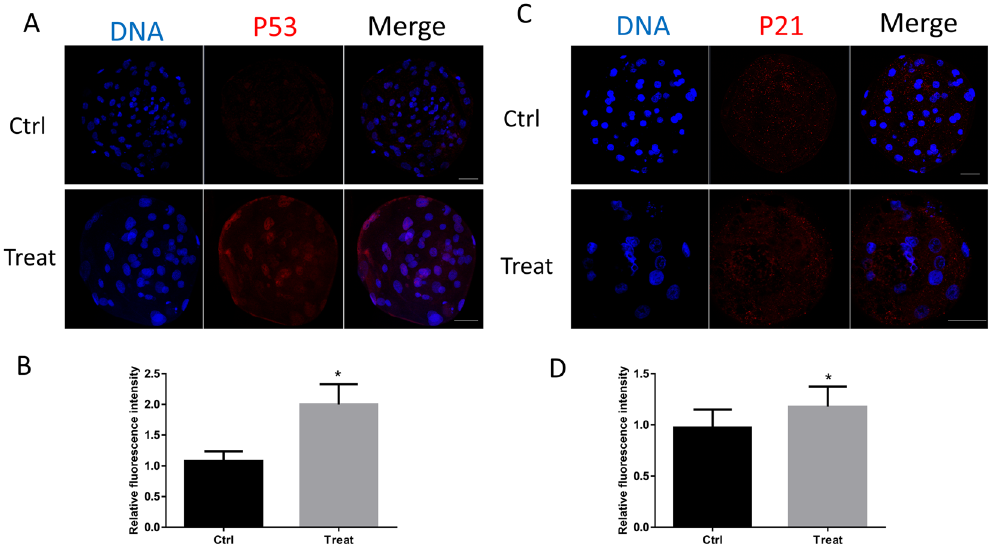
Figure 4. BPA treatment triggers the activation of the p53 pathway. ( A ) Staining for p53 showed its activation and expression. ( B ) The relative intensity of p53 is shown as bars. ( C ) Laser scanning confocal microscopy images of immunostaining for p21. ( D ) The relative intensity of p21 was measured. * P < 0.05. Ctrl, control; Treat, treatment. Scale bar: 50 μ